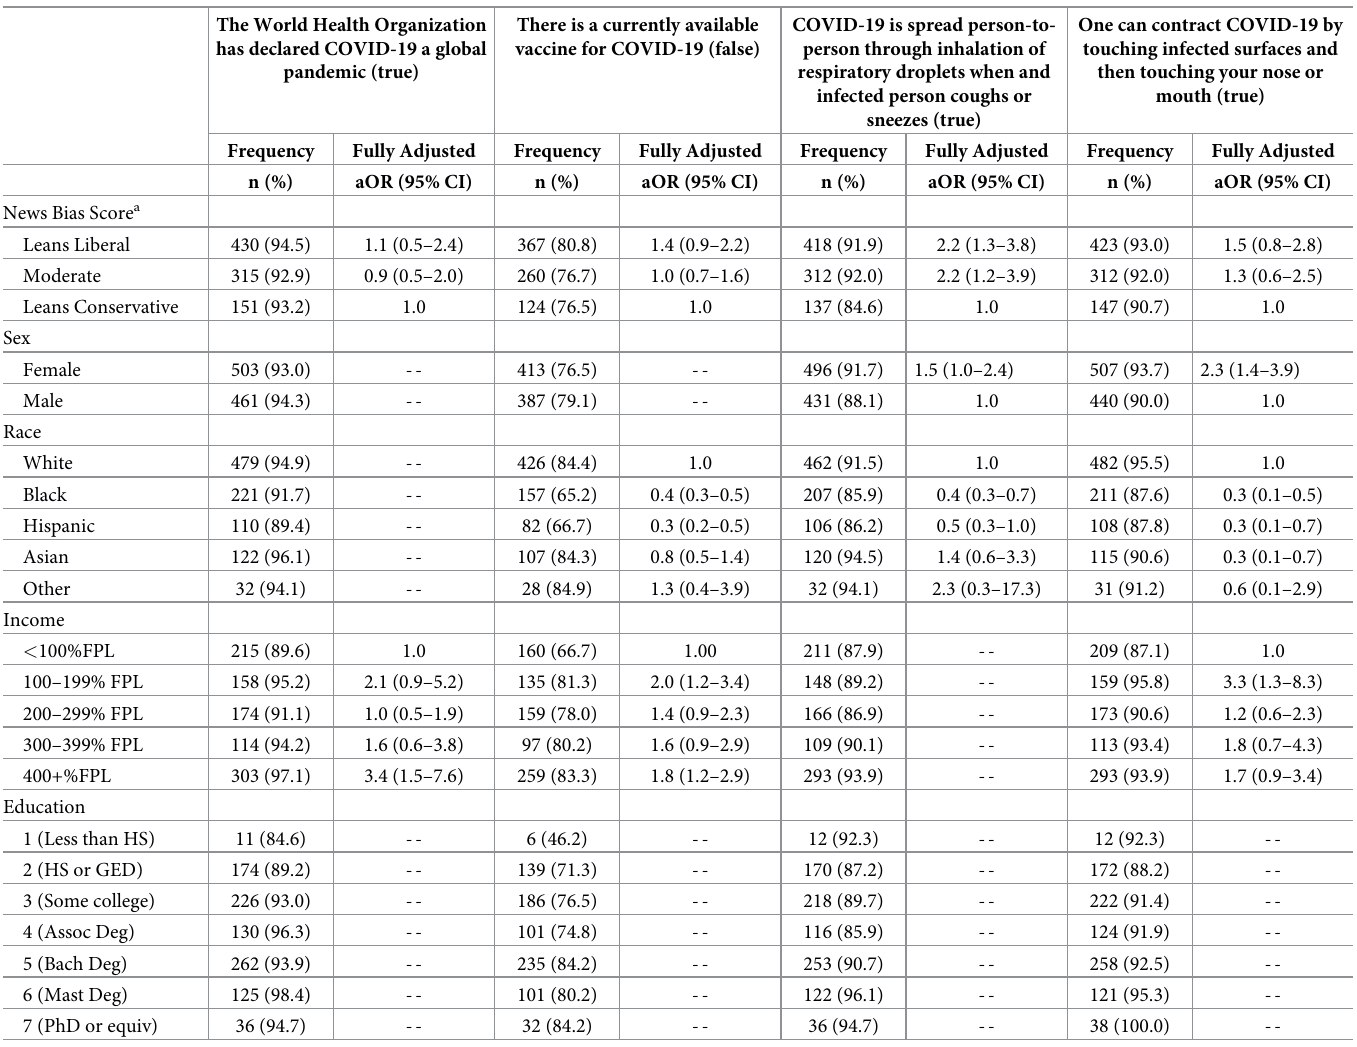
Table 6. Sociodemographic and media influences on general knowledge of COVID-19. The World Health Organization has declared COVID-19 a